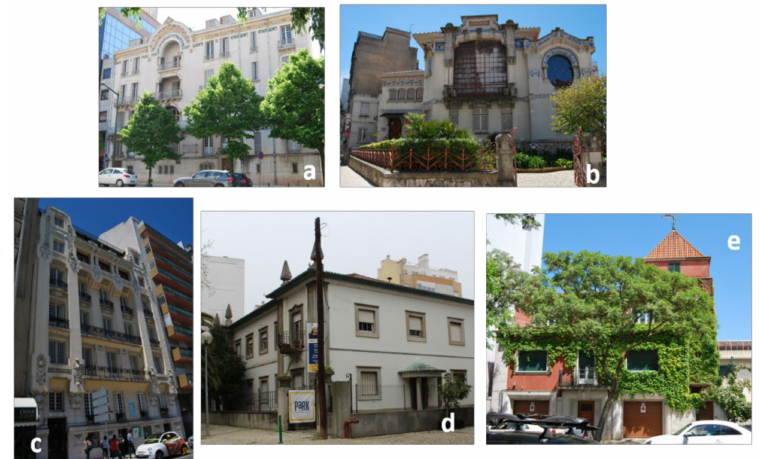
Figure 1. PRCBs case studies (acronym and award-winning year): ( a )—CVT (1903); ( b )—CMAG (1905); ( c )—AR49 (1923); ( d )—CBP (1939); ( e )—AAC (1944).